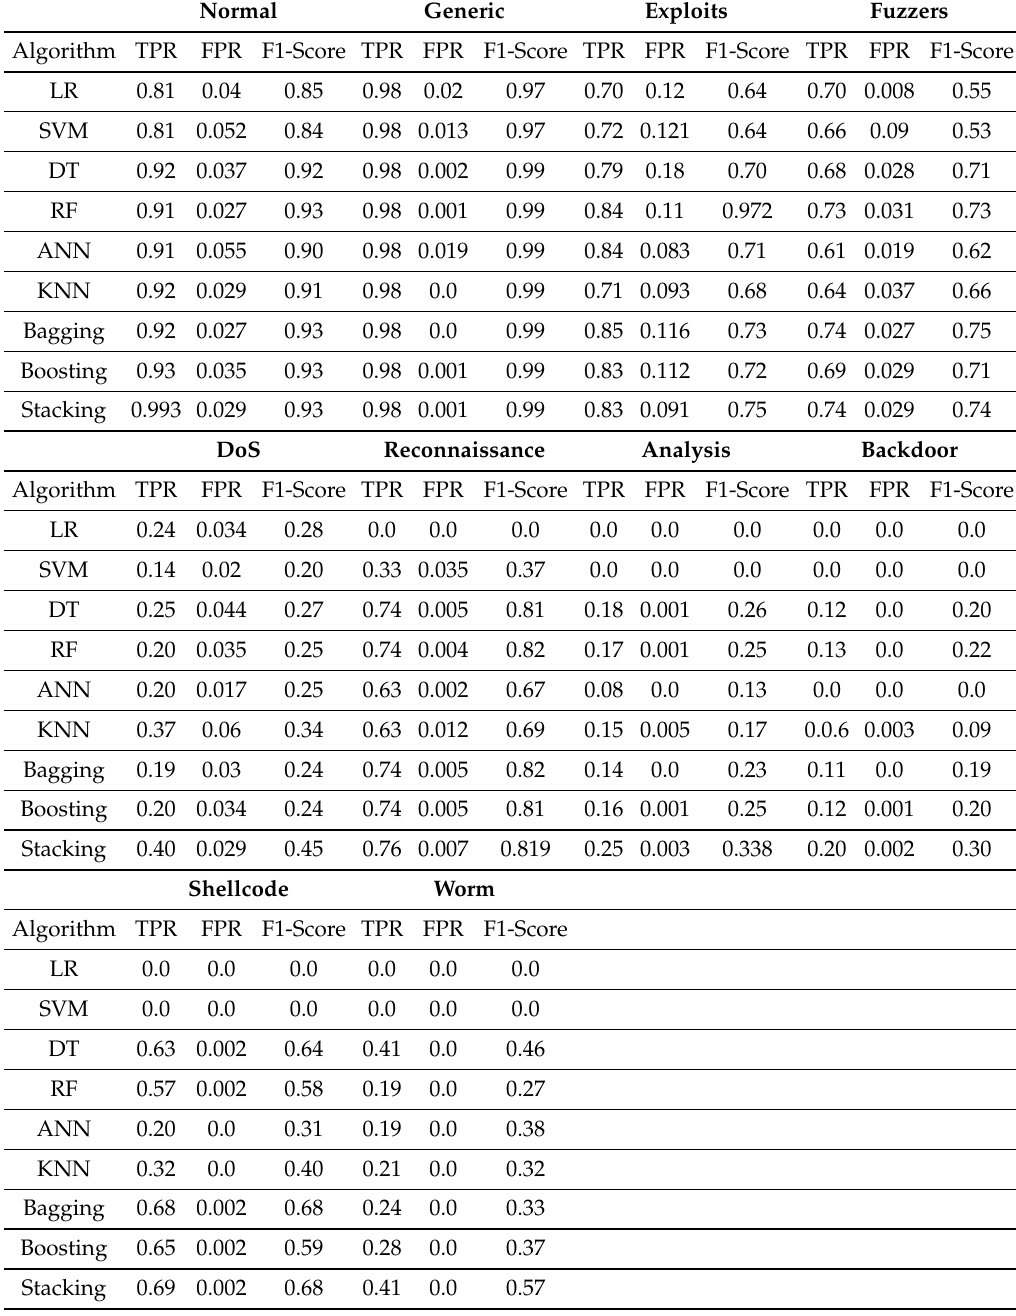
Table 5. Detection of various classes in multi-class scenario on UNSW-NB15 dataset. Normal Generic Exploits